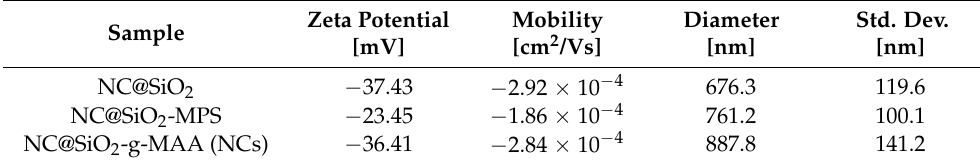
Table 1. Zeta potential values and mean diameter of NCs at pH 7.